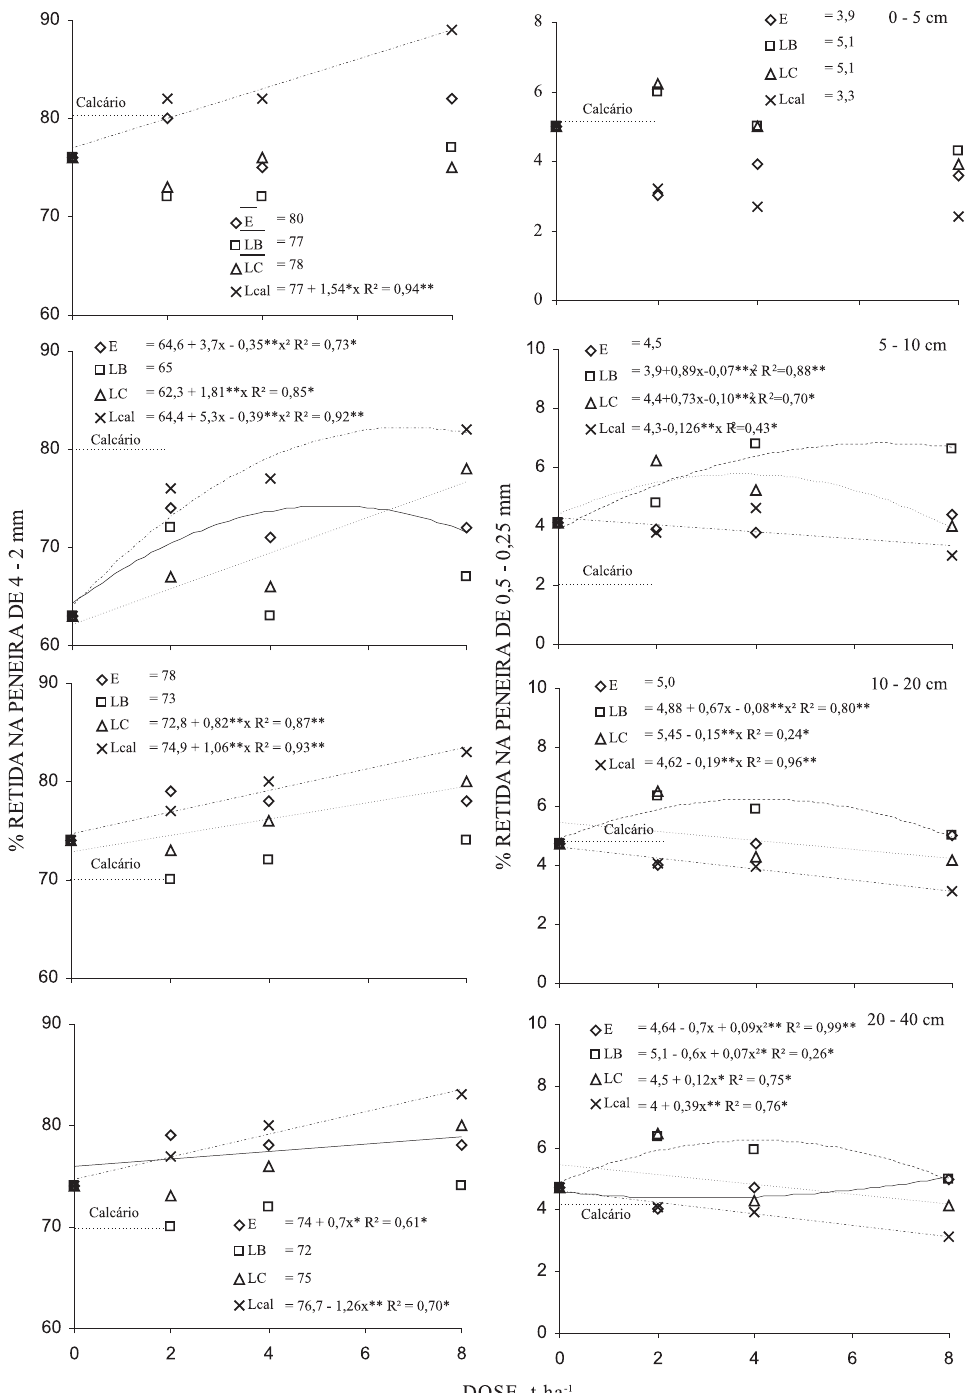
Figura 1. Percentagem de agregados retidos nas peneiras de 4–2 e 0,5–0,20 mm em função da aplicação dos resíduos e calcário aos 27 meses após a aplicação. As siglas E, LB, LC e Lcal são escória de aciaria,